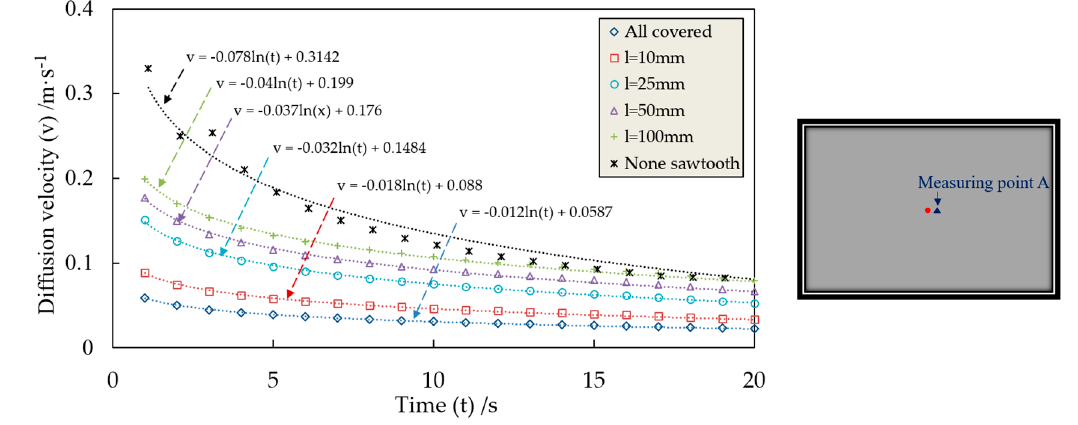
Figure 23. Decrease in the grouting diffusion velocity with time along the x+ direction.